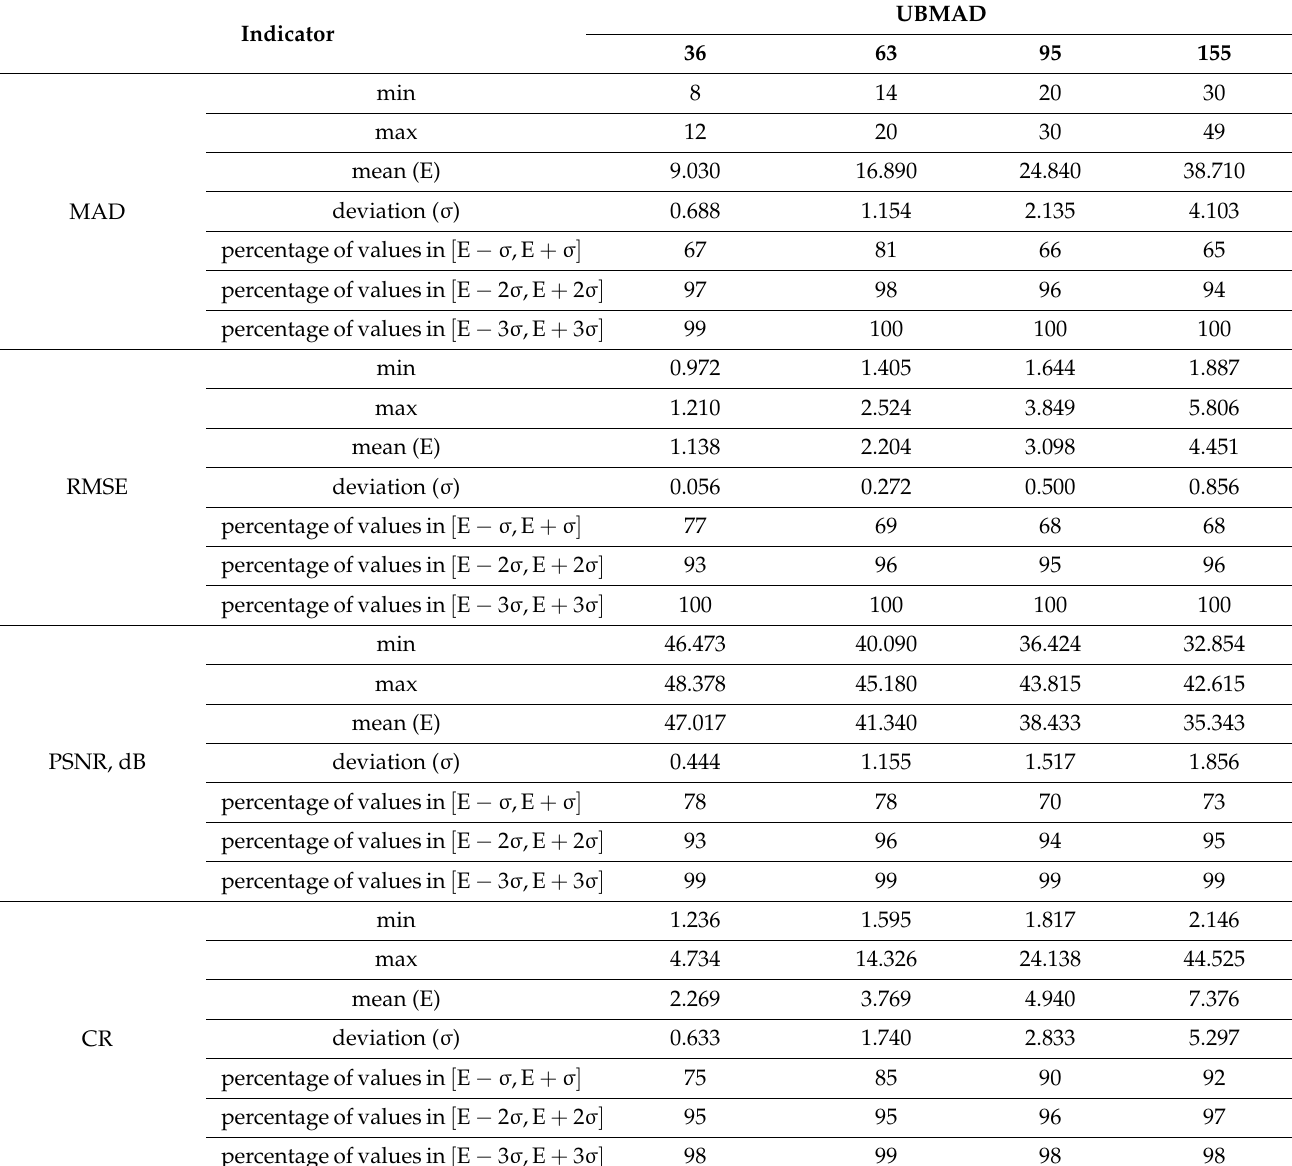
Table 2. DAT1 of the depth 5: indicators of compression